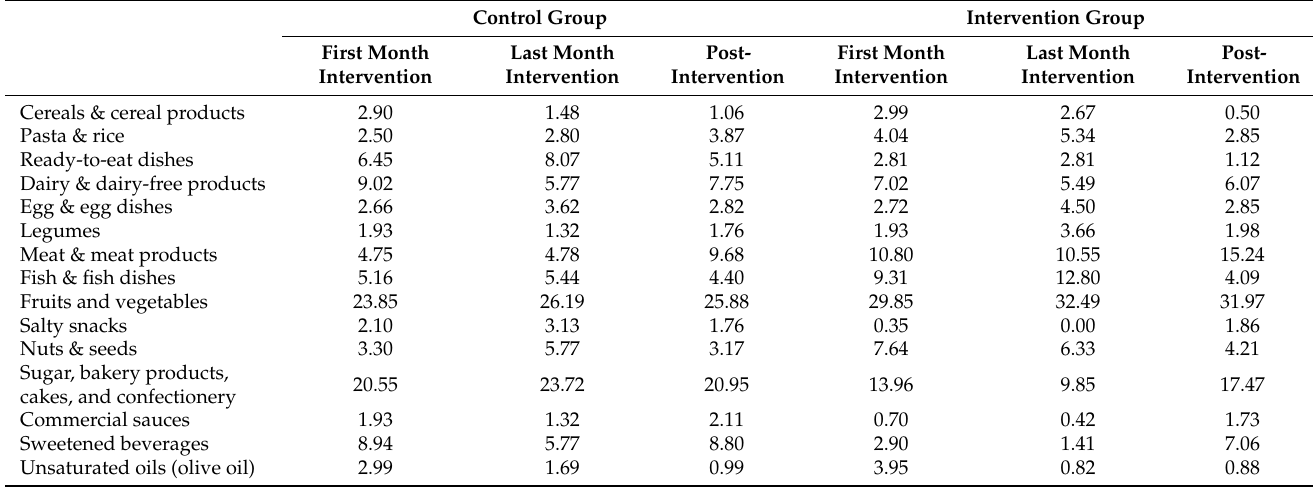
Table 5. Distribution of the frequency of purchase of the different food groups by family unit (in